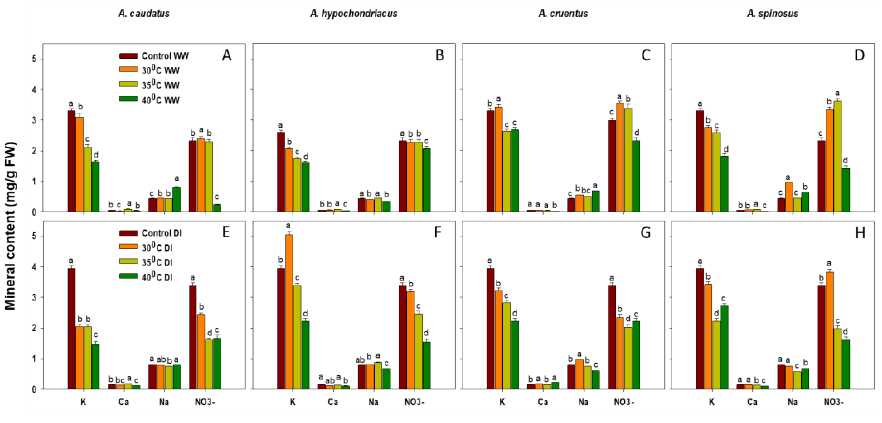
Figure 1. The effects of 30 °C, 35 °C and 40 °C temperature regimes under well-watered (WW) ( A – D ) and water-stressed (DI) ( E – H ) conditions on the mineral content of A. caudatus , A. hypochondriacus , A. cruentus and A. spinosus . Each vertical bar represents the mean value, and vertical line is a mean standard error (±) at 95% confidence level. Values among each species with the same letter(s) are not significantly different at p ≤ 0.05.